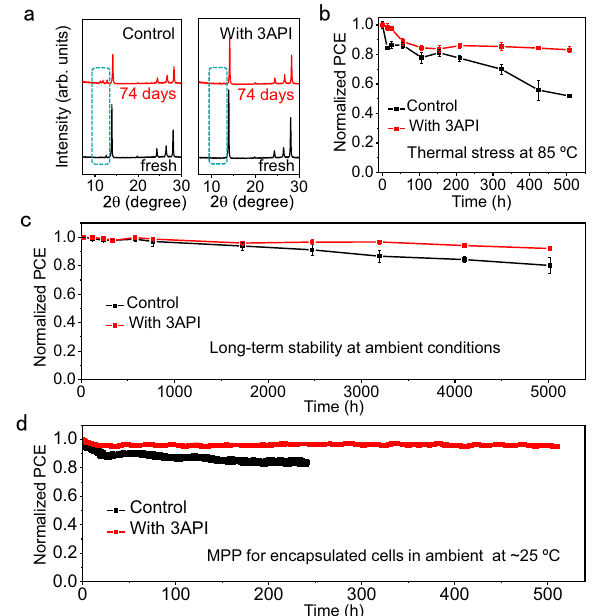
Fig.5|Stabilitystudiesofperovskite fi lmsandsolarcells.a XRDpatternsofthe controland3AP-basedperovskite fi lmsrecordedbeforeandafteragingfor74days. b PCE evolution observed for the control and 3AP-based devices stored without encapsulation at 85°C under a nitrogen atmosphere. c PCE evolutionobserved for the control and 3AP-based devices stored without encapsulation at ambient con- ditions (25°C and 30 – 40% relative humidity). d Stabilized maximum power point (MPP) values recorded for the control and 3AP-based devices with encapsulation under continuous light irradiation with a white LED lamp at 100mWcm – 2 in ambient (25°C and 30 – 40% relative humidity). All the error bars represent the standard deviation for devices. Source data are provided as a Source Data fi